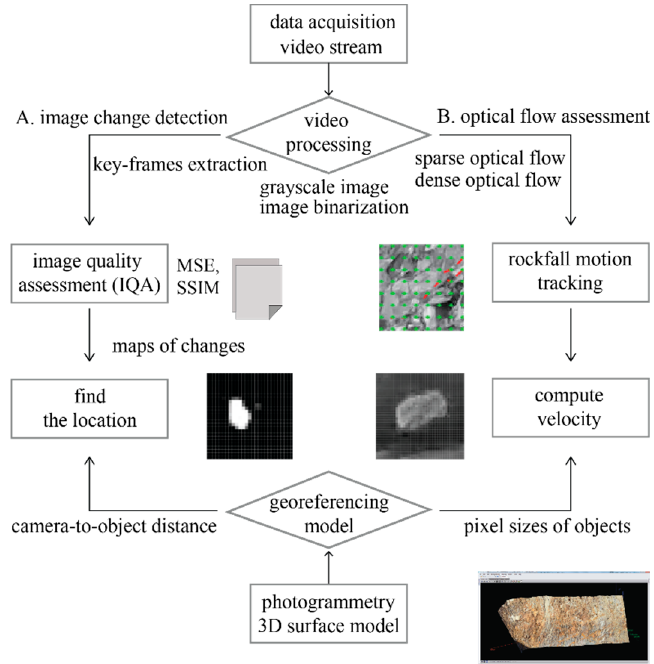
Figure 1. Flow chart of proposed method.